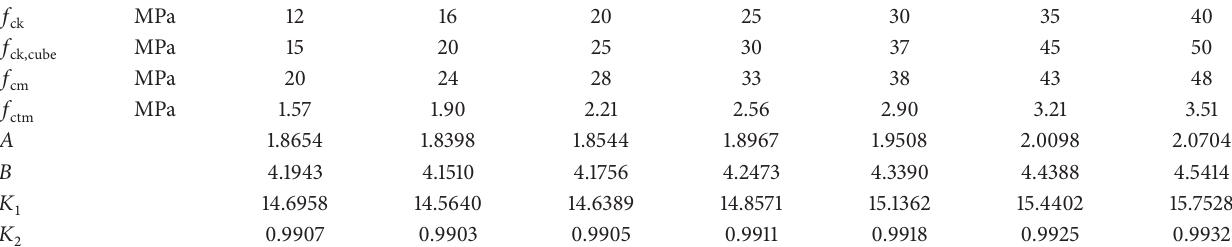
Table 8: Ottosen parameters for Eurocode concrete strength classes C12–C40.